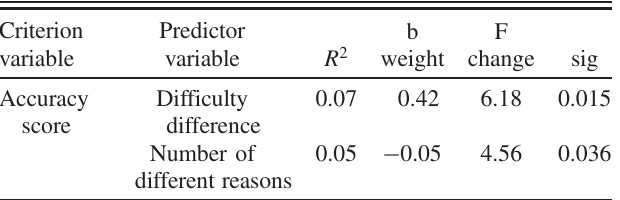
TABLE III. Predictors of accuracy of judgment scores for PER experts; note N ¼ 77